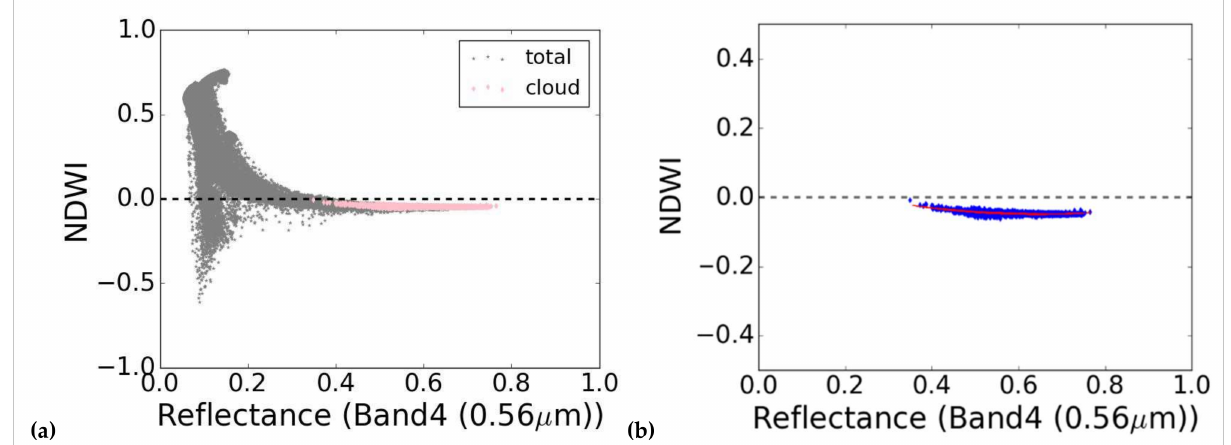
Figure 5. ( a ) Distribution of cloud pixels and ( b ) regression relationship between NDWI and MODIS R 0.56 µ m for cloud pixels on 1 June 2017, 02:15 UTC. The pink pixels in ( a ) are clouds selected from the RGB image. The grey pixels in ( a ) denote all MODIS pixels on the same date. Blue pixels in ( b ) indicate the cloud pixels. The red line in ( b ) is the regression relationship for cloud